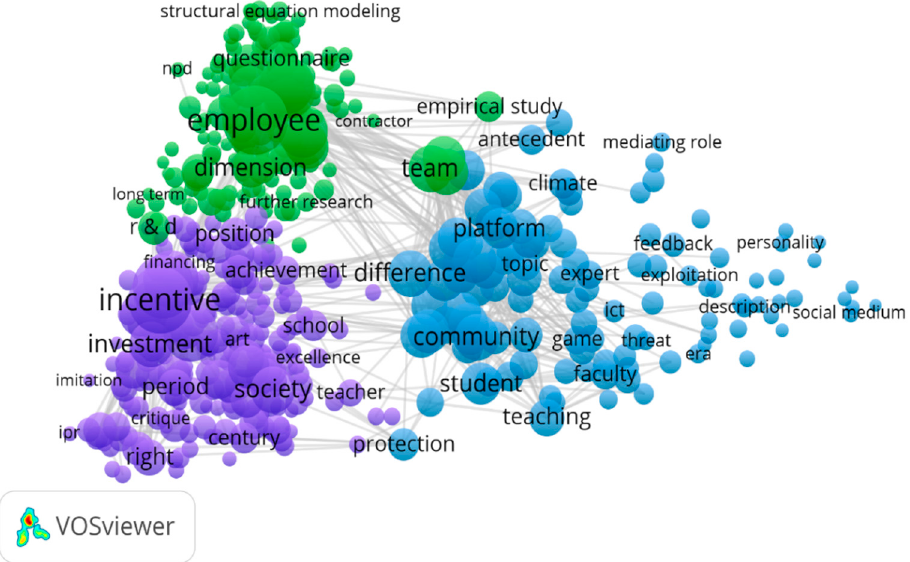
Figure 8. Network analysis of keywords. Source: created by the authors.